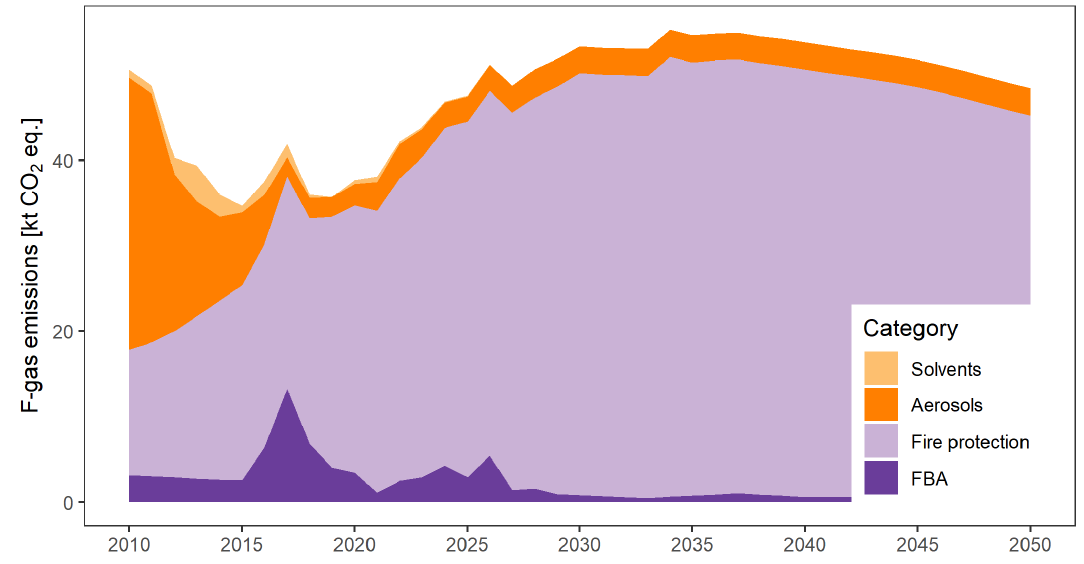
Figure 6. Other F-gas use emission projections.